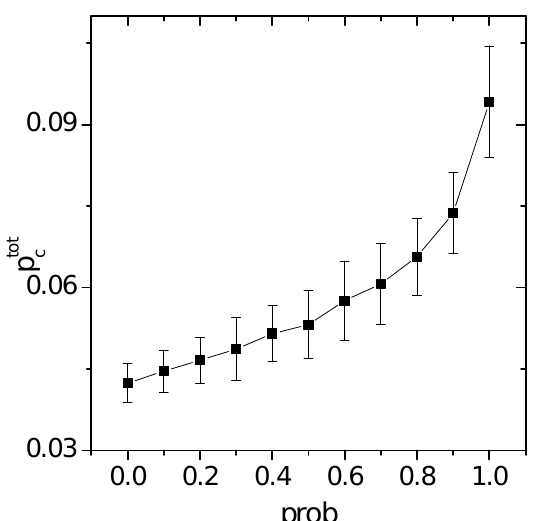
Figure 6. Dependence of the percolation concentration for hybrid composites of different